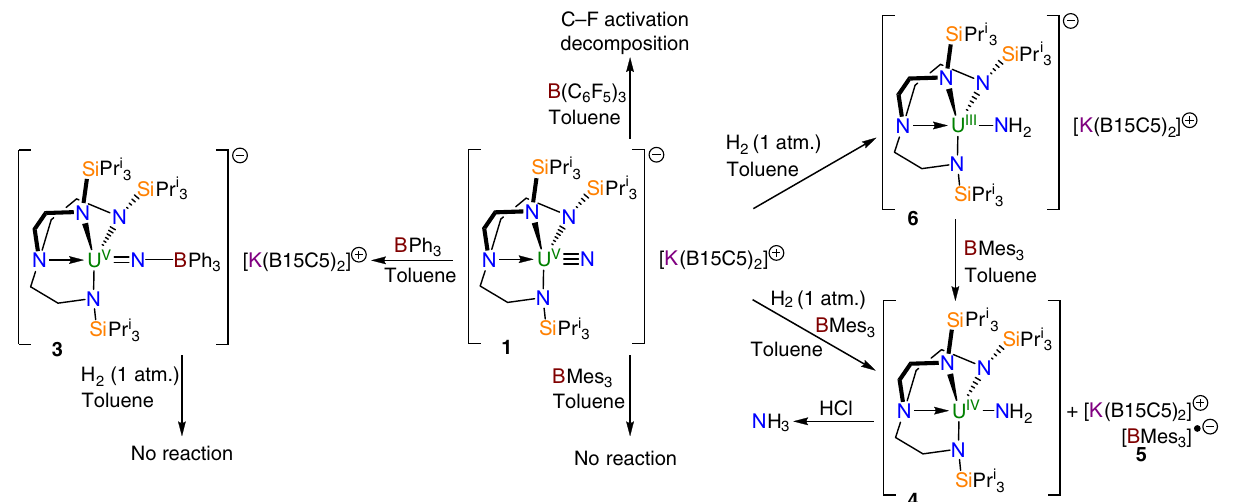
Fig. 1 Synthesis of complexes 3 – 6. Treatment of 1 with the strong Lewis acid B(C 6 F 5 ) 3 results in decomposition, however the milder borane BPh 3 produces the capped species 3 , which is inert with respect to reaction with H 2 . Complex 1 does not react with the sterically encumbered BMes 3 , but exposure of that mixture to H 2 produces the amide complex 4 with concomitant formation of the radical anion complex 5 . Addition of H 2 to 1 produces the amide complex 6 , and subsequent treatment with BMes 3 produces 4 and 5 . Treating 4 with HCl produces NH 3 . B15C5 = benzo-15-crown-5 ether. Mes = 2,4,6-trimethylphenyl.